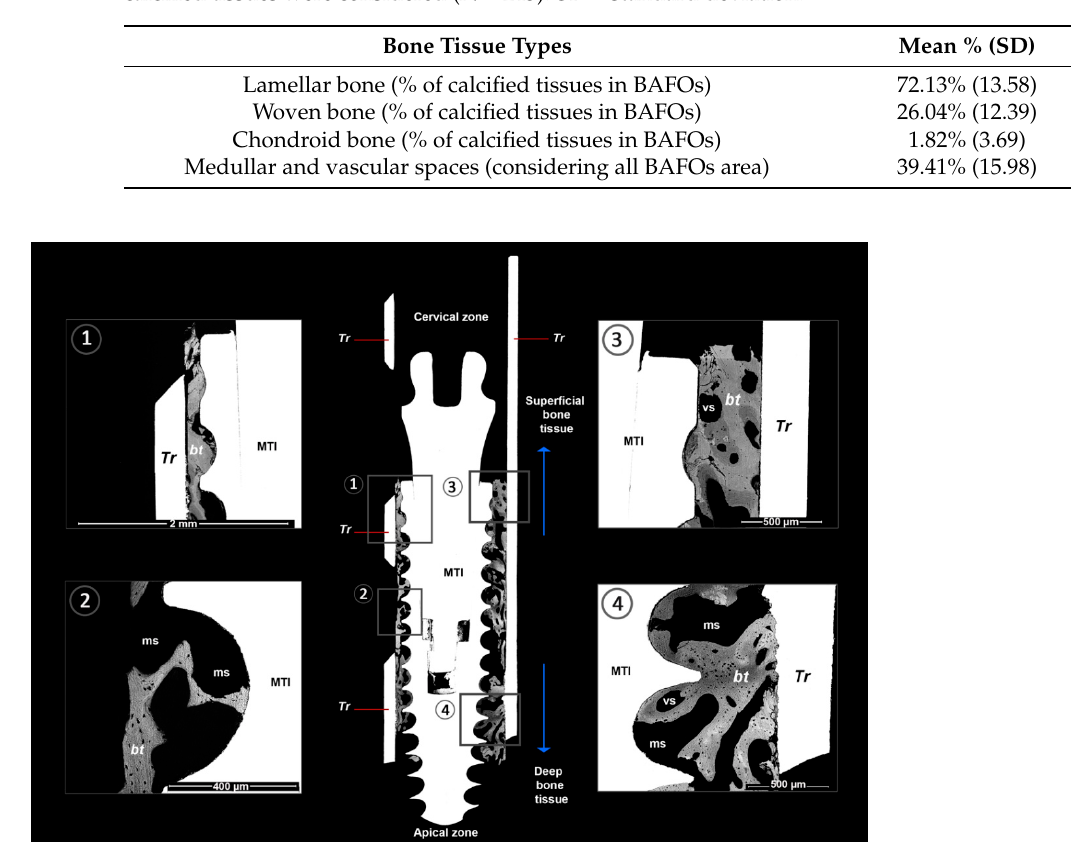
Figure 3. BS-SEM osseointegration between grade V titanium mini-transitional implants (MTI) and the bone surface. The BS-SEM image shows close contact between the implant surface and bone. Furthermore, bone tissue with an advanced degree of maturation and mainly lamellar and fibroreticular tissue organization is observed overall. The subfigures 1 – 4 show details of the BAFOs in the central image. MTI = mini transitional implant, Facility ® ; Tr = trephine; bt = bone tissue; ms = medullar space; vs = vascular